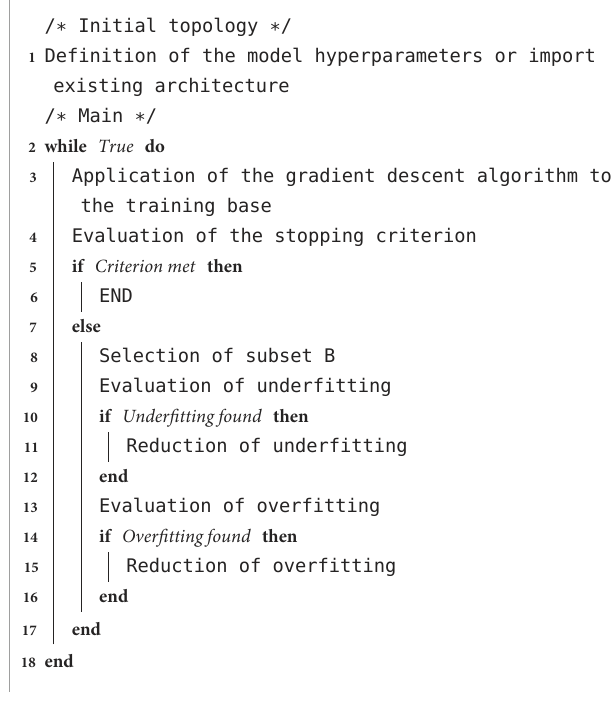
Algorithm 1. Simple incremental